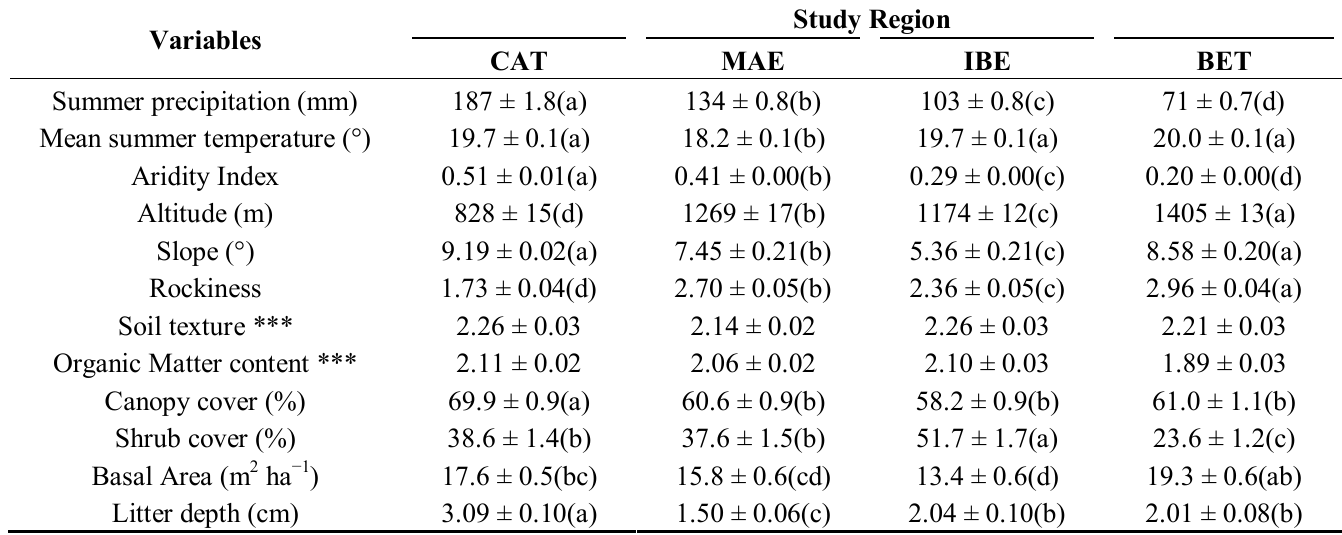
Table 1. Mean values and standard errors of the abiotic and stand-structural variables measured in 170 plots with presence of seedlings from each study region. Aridity Index = summer precipitation/potential evapotranspiration during summer. Lower values of the index represent drier conditions. The period June-July-August was considered as summer. Different letters between brackets indicate significant differences in a Tukey HDS test (differences were considered significant at p < 0.005 after Bonferroni corrections for 10 variables). *** Significant differences ( p < 0.001) in a Kruskal-Wallis